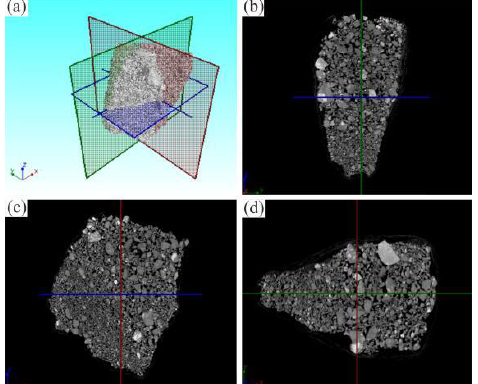
Figure 8. CT scanning of irregular soil sample. ( a ) 3D model of irregular sample. ( b ) X-section. ( c ) Y-section. ( d ) Z-section.